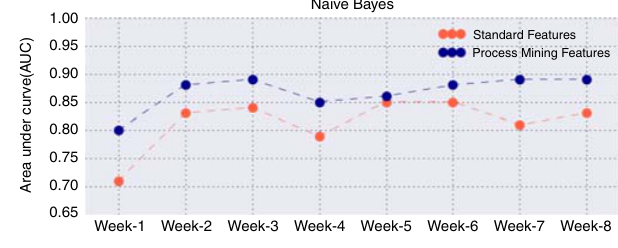
Figure 10. Comparative results of random forest method on the data set consisting of process mining features and